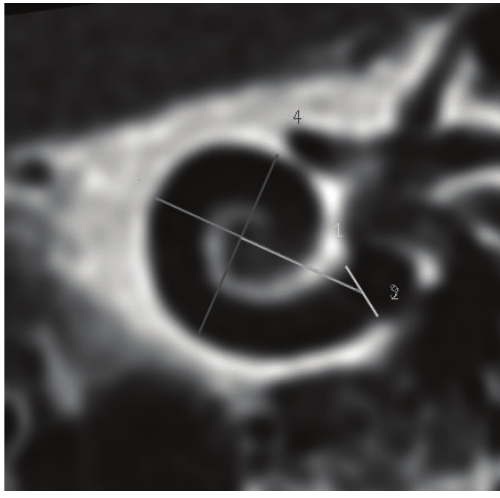
Figure 1: Flat-panel-based determination of cochlear size. Midth modiolar rectangular lateral wall distance (4) was used for the determination of cochlear size. (2) scalar size, (1) transmodiolar distance.